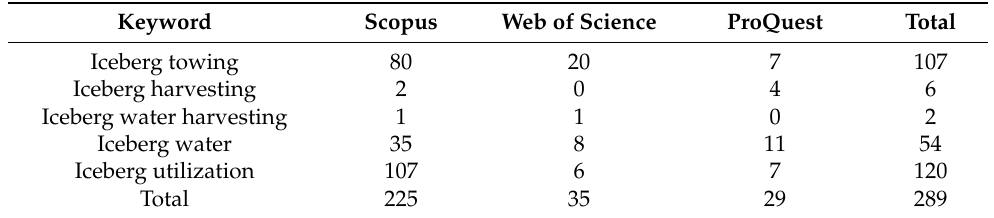
Table 1. Number of publications located in the three search engines using different search terms.